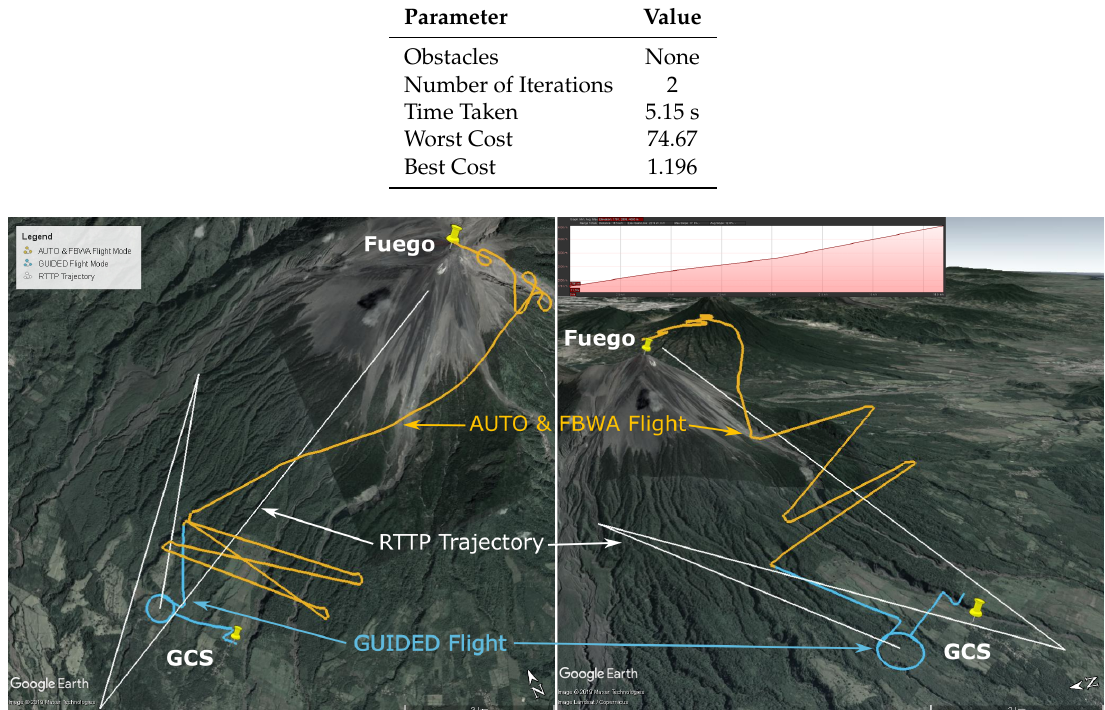
Figure 4. Flight A data: top down (left) and 3D (right) maps showing the Real Time Trajectory Planner solution (white) and the actual flight path (Guided: Blue, Auto/FBWA: Orange) in Google Earth [29]. The elevation profile of the RTTP Trajectory is inset (top, right).